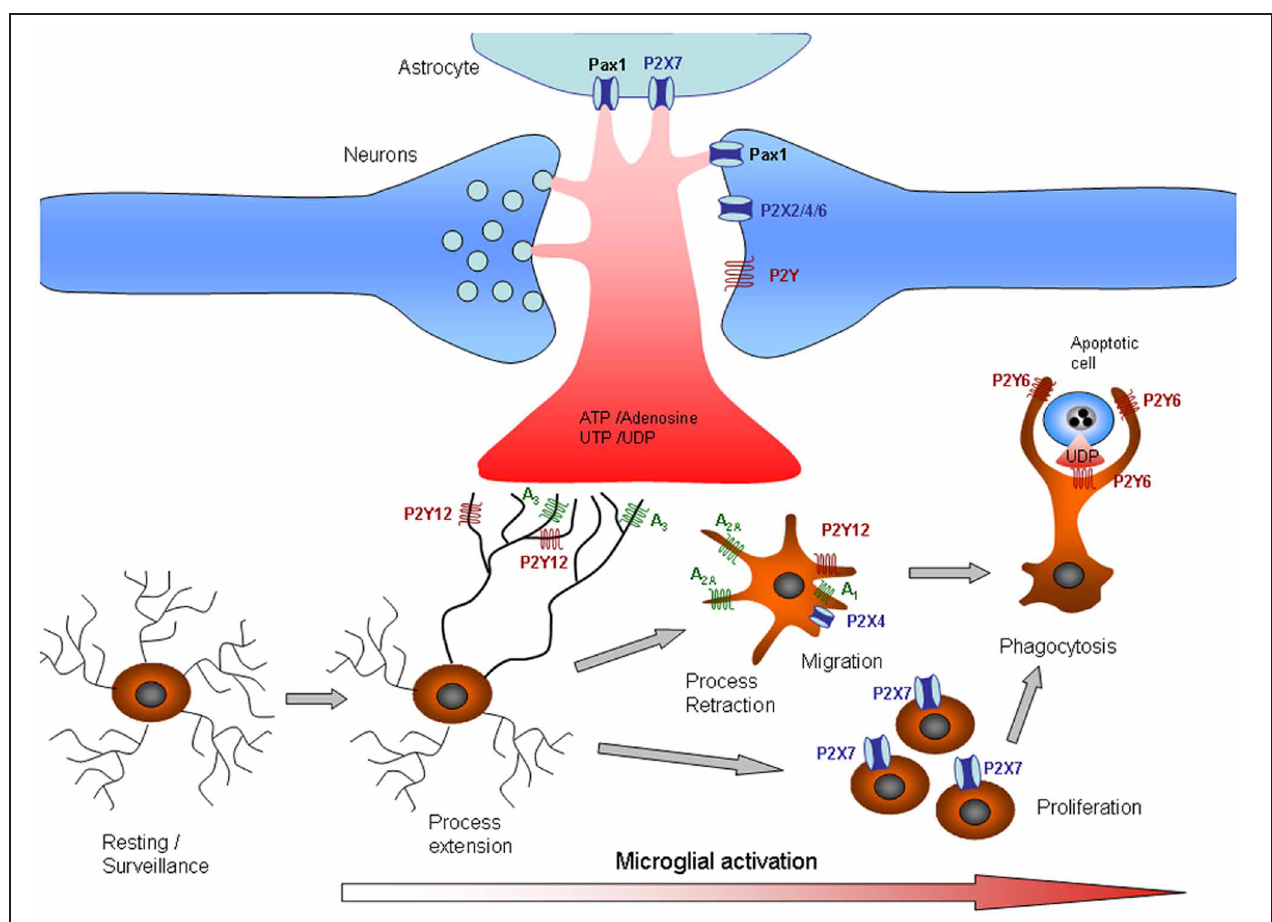
ameboid morphology, cell body migration, and increasing phagocytic ability. The changes in microglial functions are partly associated with changes in purinergic receptors that determine different responses to ATP. Thus, process retraction is mainly due to upregulation of A 2A and downregulation of P2Y12 receptors, whereas migration is mediated by A 1 and P2X4 receptors and proliferation by P2X7 receptors. Phagocytosis signaling is also unmasked by the upregulation of P2Y6, which is activated by the release of UTP by dying cells. See also Table 1